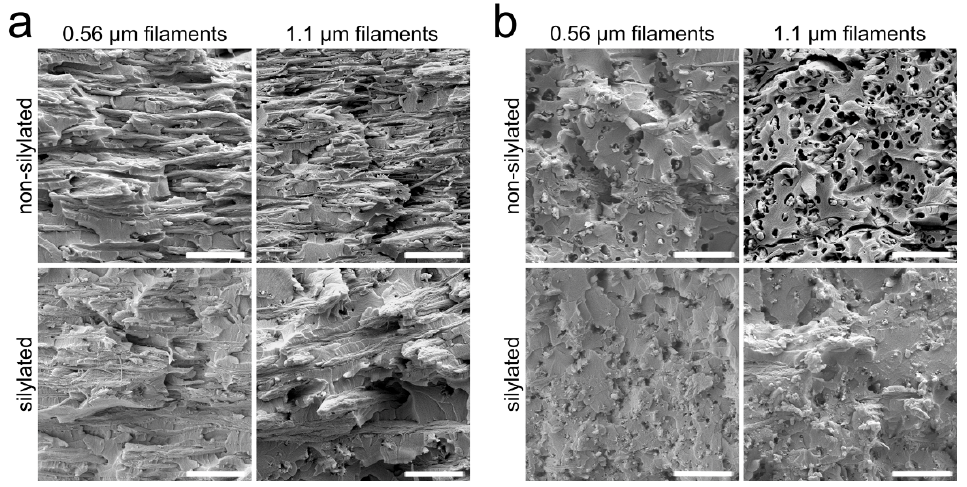
Figure 6. Composite morphology. Longitudinal ( a ) and transverse ( b ) fracture surfaces of the CNF filament/epoxy composites. (The scale bar is 5 µm in all images.)